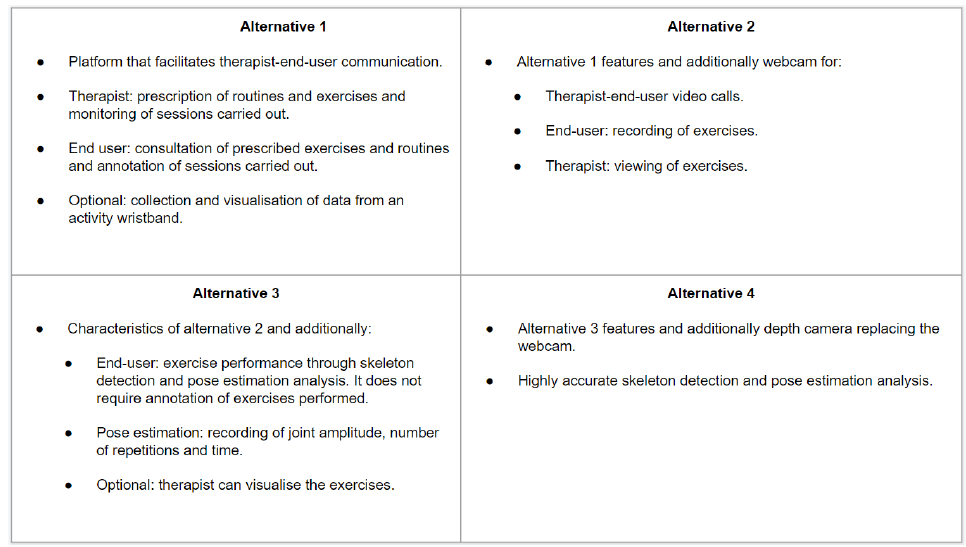
Figure 2. Details of the four alternatives with respect to the usefulness